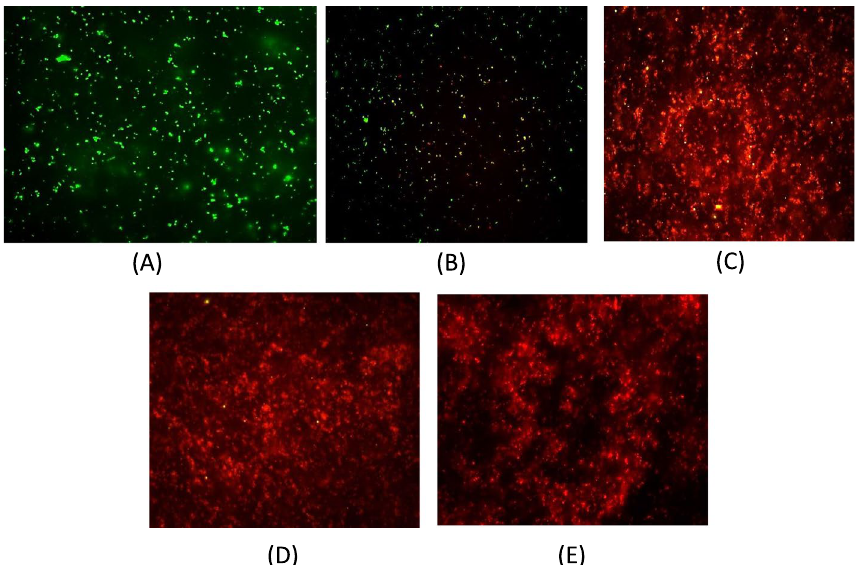
Fig. 12 SYTO 9-PI staining of expression host, E.coli after IPTG induction during recombinant production of Pp -ALF A 0 th h, B 1 st h, C 2 nd h, D 4 th h, and E 6 th